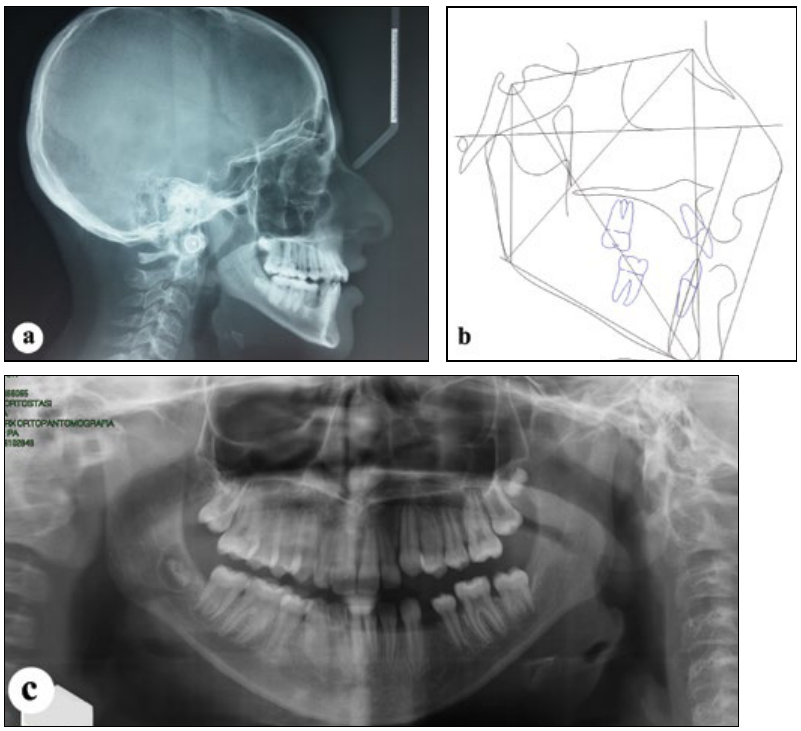
Figure 4. Post-treatment radiographic images. (a) Lateral cephalogram. (b)Tracing. (c) Panoramic